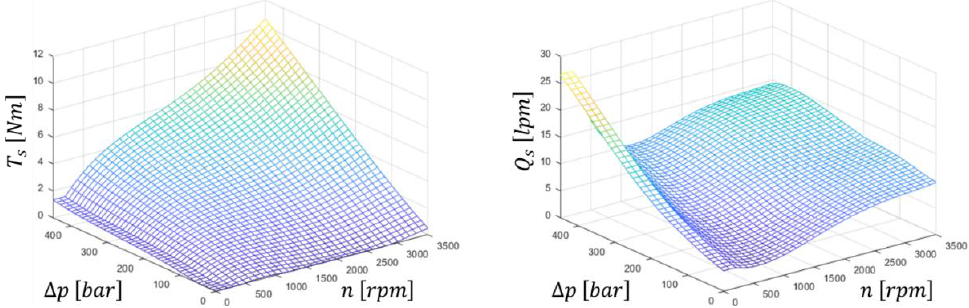
Figure 13. Volumetric ( Left ) and Hydromechanical ( Right ) Loss Model.